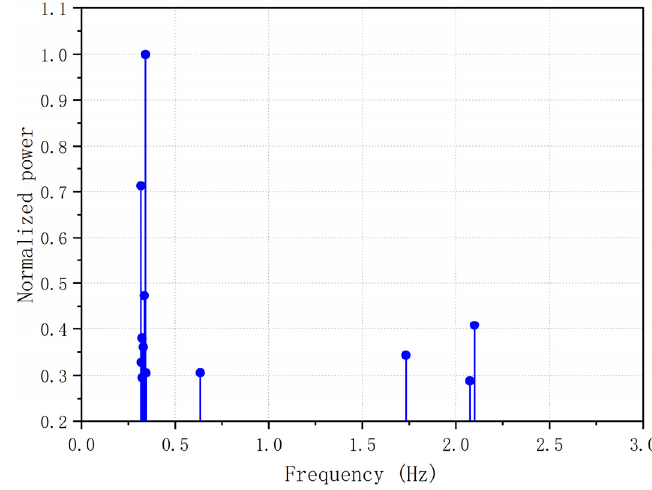
Figure 11. The results of practical data by SFFT.